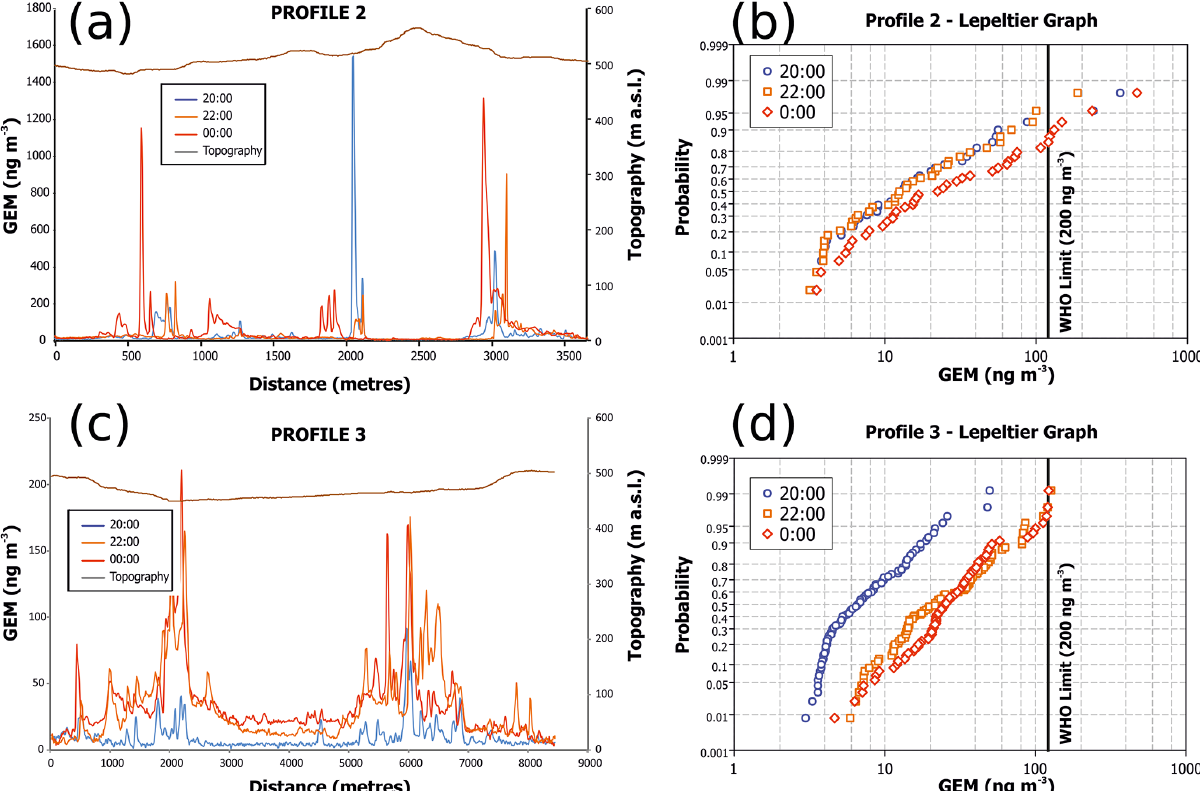
Figure 8. Nocturnal GEM levels in Almadenejos and surroundings. Summer average represents the average of diurnal GEM measurements in summer surveys. Panels (b) and (d) are the Lepeltier curves of datasets in panels (a) and (c) , respectively. Table 4. Micrometeorological conditions for TGM outdoor values to exceed the WHO limit for chronic exposure of 200ngm − 3 . Abbrevia- tions: T : temperature; RH: relative humidity; WindSp: wind speed; and SR: solar radiation. T ( ◦